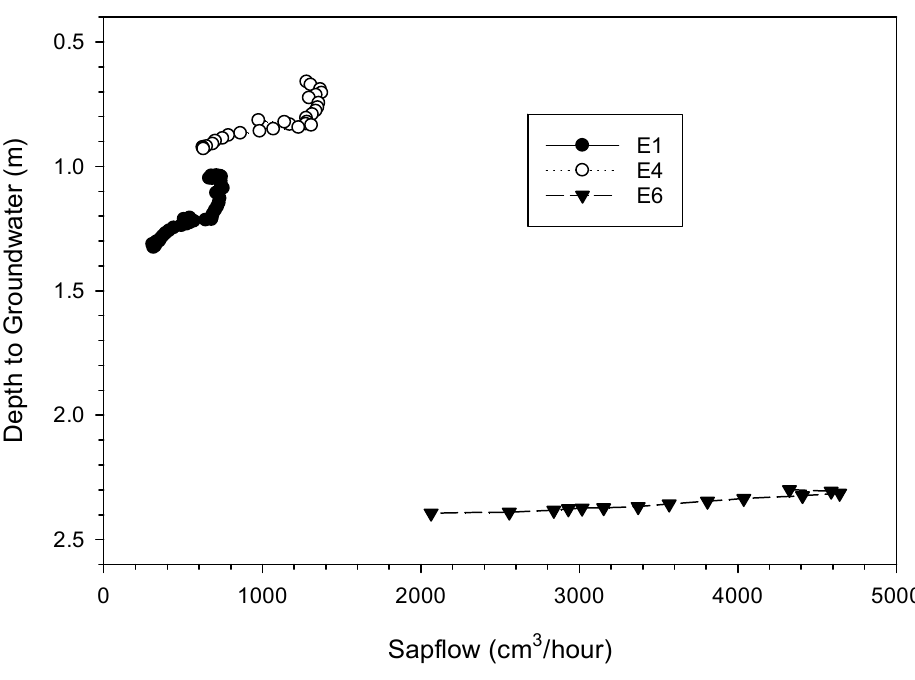
Figure 7. Depth to groundwater vs. average hourly sap flow rate for each day for the three Eucalypus tessellaris trees that exhibited declining sap flow rates during the period of declining groundwater in late November and early December 2011.